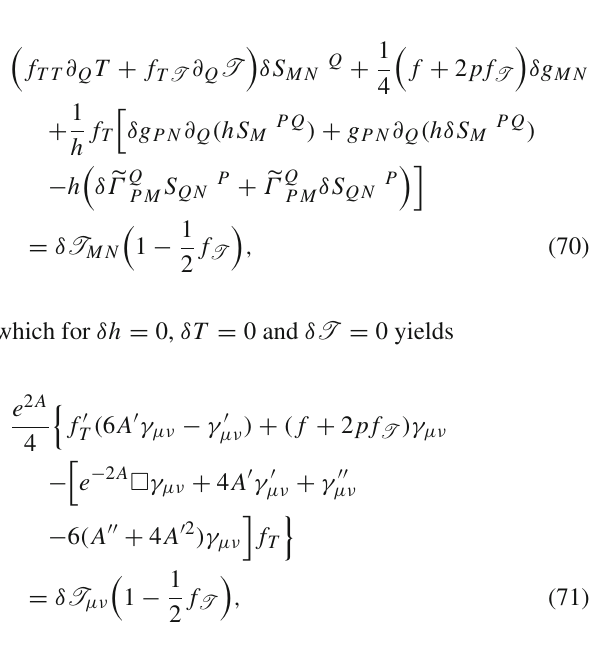
Fig. 6 Plots of the kink solution ( a ), warp factor ( b ), potential ( c ), energy density ( d ), where k 1 = 0 . 05 and α = β =